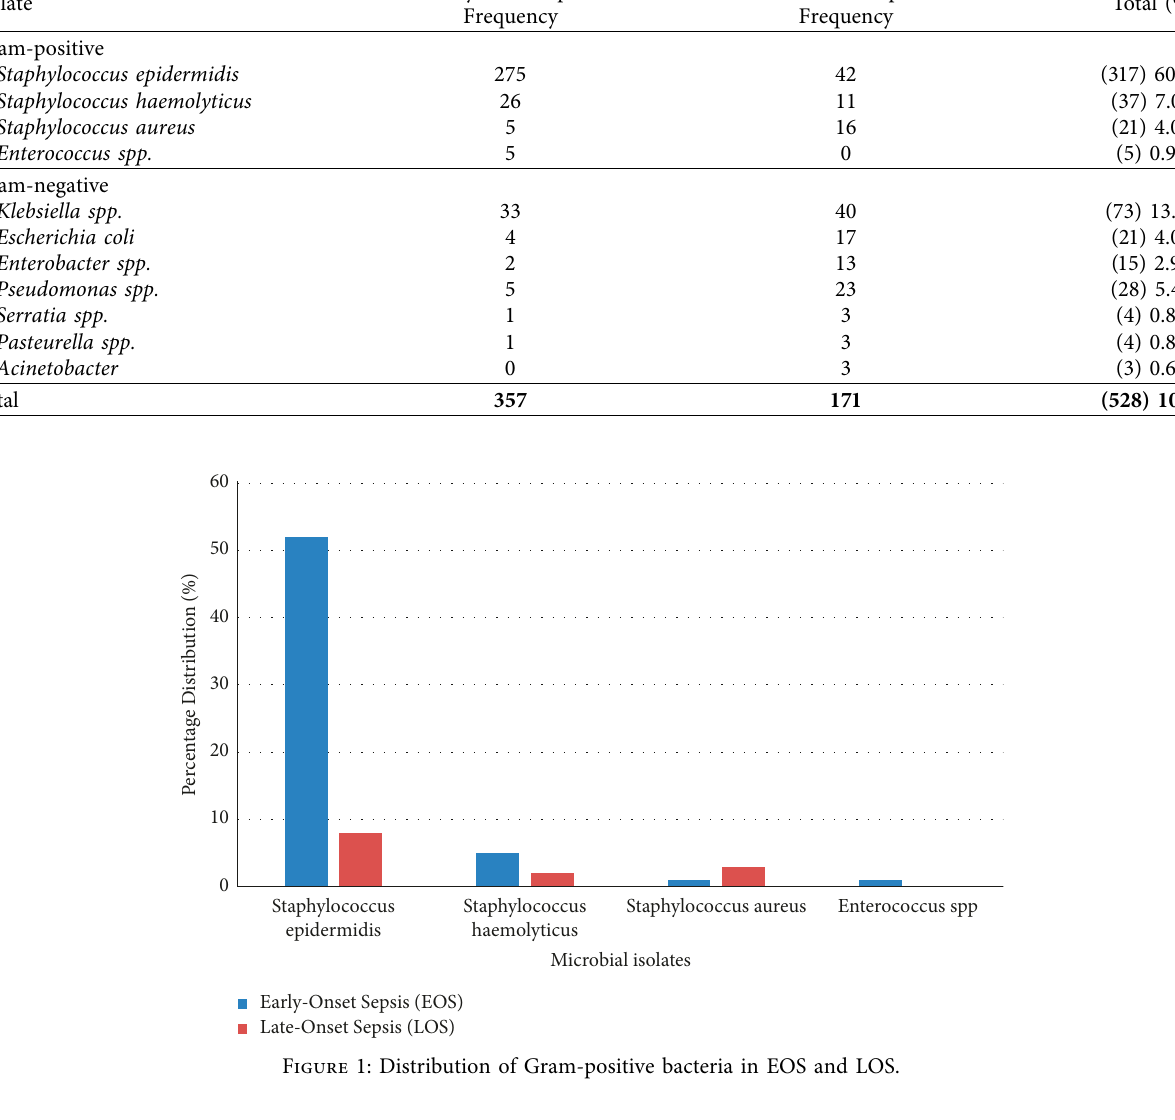
Table 1: Bacteria isolated from blood cultures of neonates with sepsis ( n � 528) at the Greater Accra Regional Hospital. Isolate